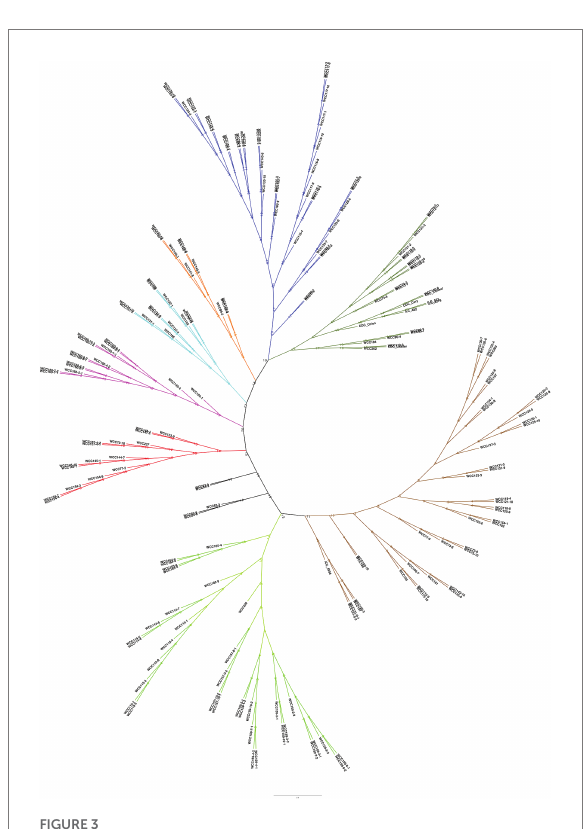
FIGURE 3 Genetic relatedness among the 203 chickpea accessions, estimated by neighbor-joining